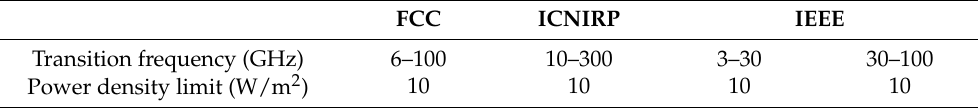
Table 1. Limit of power density.